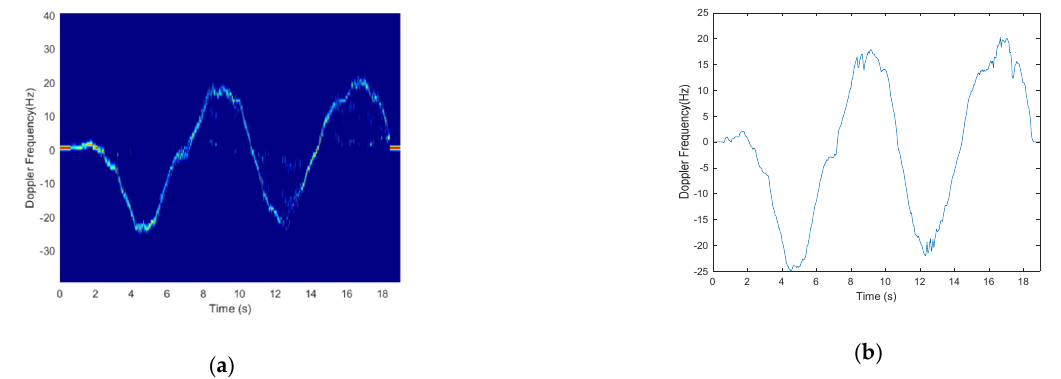
Figure 7. Doppler frequency extraction. ( a ) Frequency-time spectrum; ( b ) Doppler frequency.